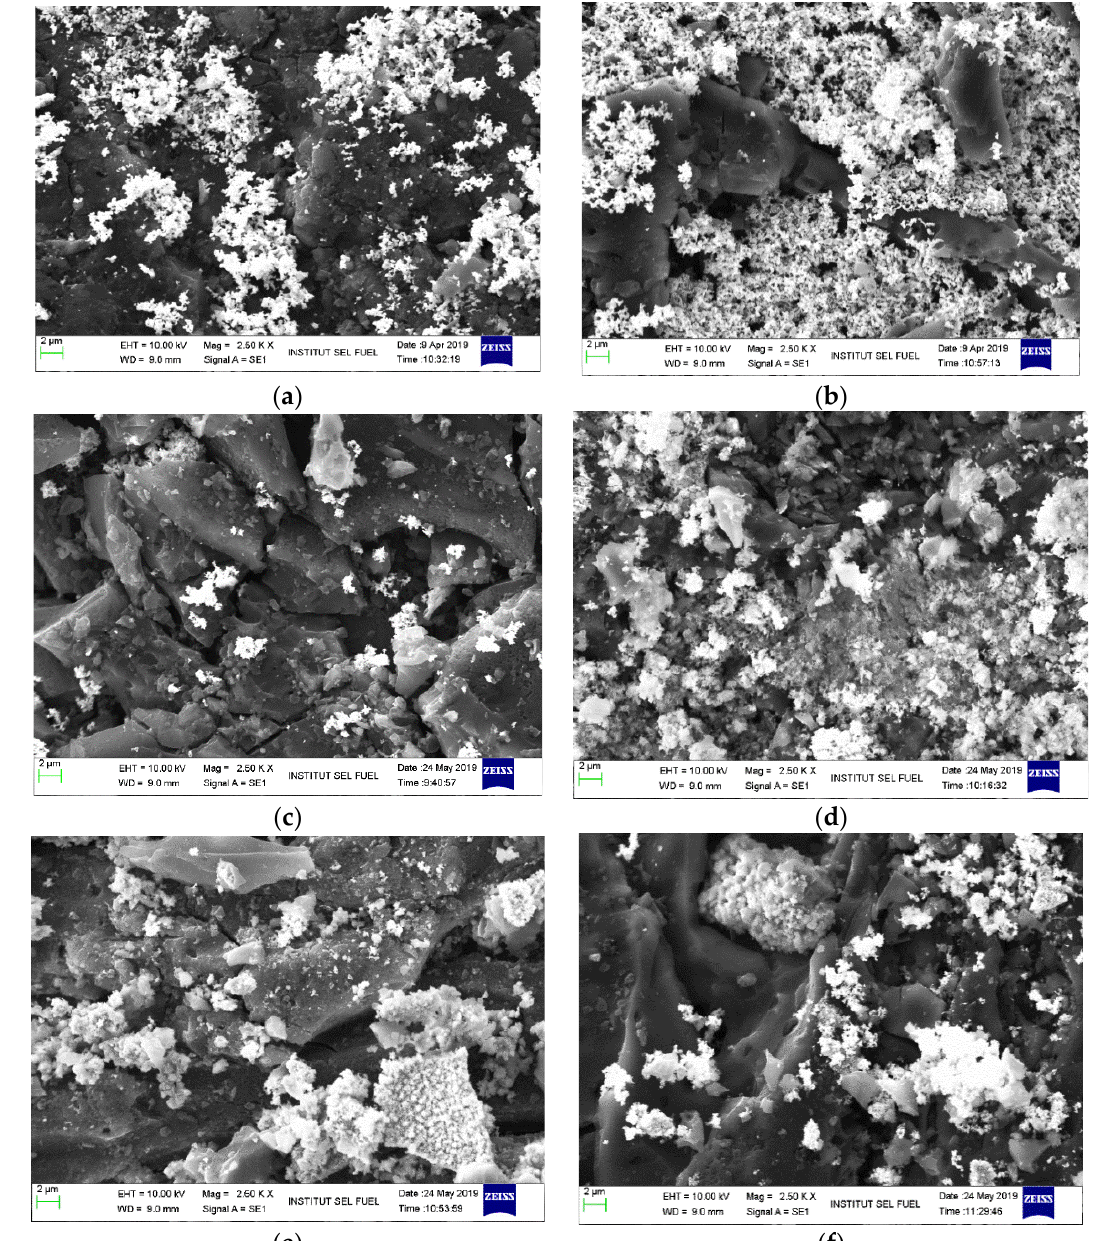
Figure 1. SEM micrograph images of a 2.5 kx (2 μm) adsorbent sample: ( a ) ZnAc 2 /ZnO/CAC_A ( b ) ZnAc 2 /ZnO/CAC_B ( c ) ZnAc 2 /KOH/CAC_A ( d ) ZnAc 2 /KOH/CAC_B ( e ) ZnAc 2 /ZnO/CAC_A ( f ) ZnAc 2 /NaOH/CAC_B.